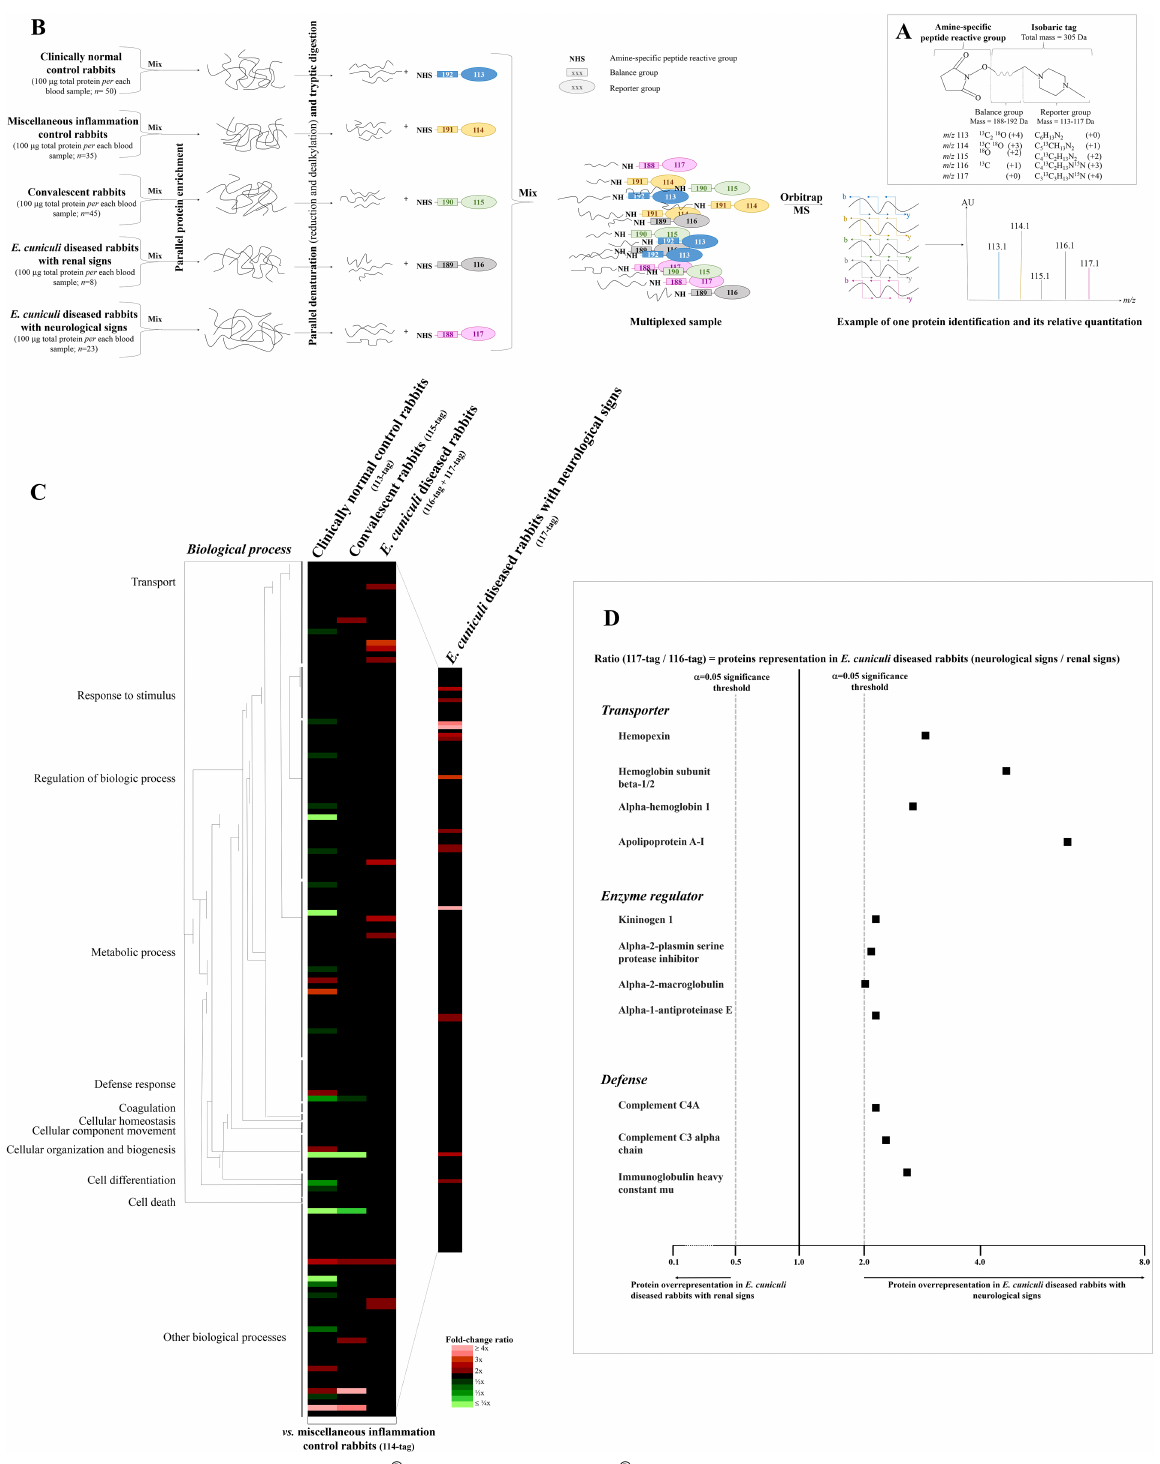
Fig 1. Study design and results for iTRAQ ® protocol. A—the iTRAQ ® reagent is designedas an isobaric stable tag consistingin a chargedreporter group that retains charge(N,N-dimethylpiperazine), a peptidereactive group (N-hydoxy-succinimide)that is amide- linkedto the N-terminus and the ε -aminoside chains of all the peptides got from prior tryptic digestion, and a neutral balanceportion (carbonyl) to maintainan overall mass of 305 kDa by the means of differentialisotopic enrichment with 13 C, 15 N and 18 O atoms. The selectionof the reporter regionin the low mass area enableskeepingthe additivemass to the fragmentsas negligibleas possiblein